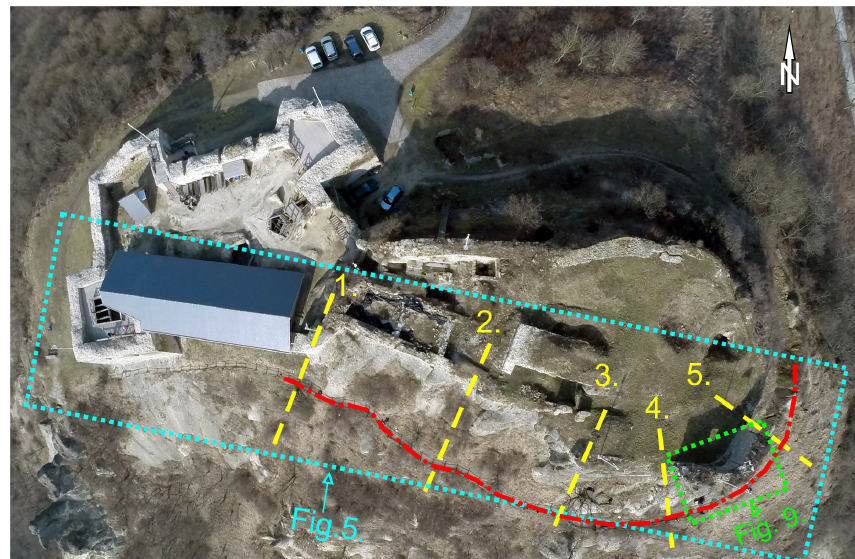
Figure 3. Location of the illustrations in the paper and the rockfall-affected area. Red dotted and dashed line represents zones affected by rockfall. Yellow dashed lines 1 to 5 mark the sections where slope stability was calculated by using 2-D FEM model (Fig. 8). Dotted lines indicate the areas shown in Figs. 5 and 9.